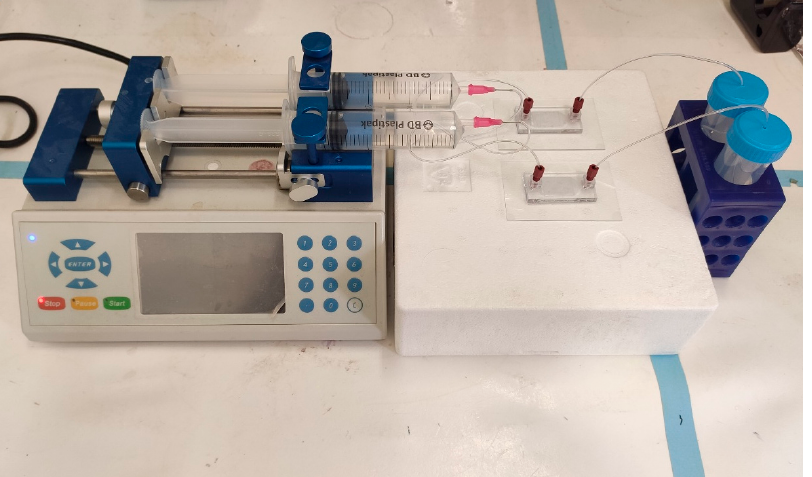
Figure 4. Set-up of the two geometries of 3D printed drug release microfluidic chips connected to the pump. Parallel assays can be performed simultaneously for different chip geometries or for different drug formulations. Once assembled, the system is maintained in 37 ◦ C.